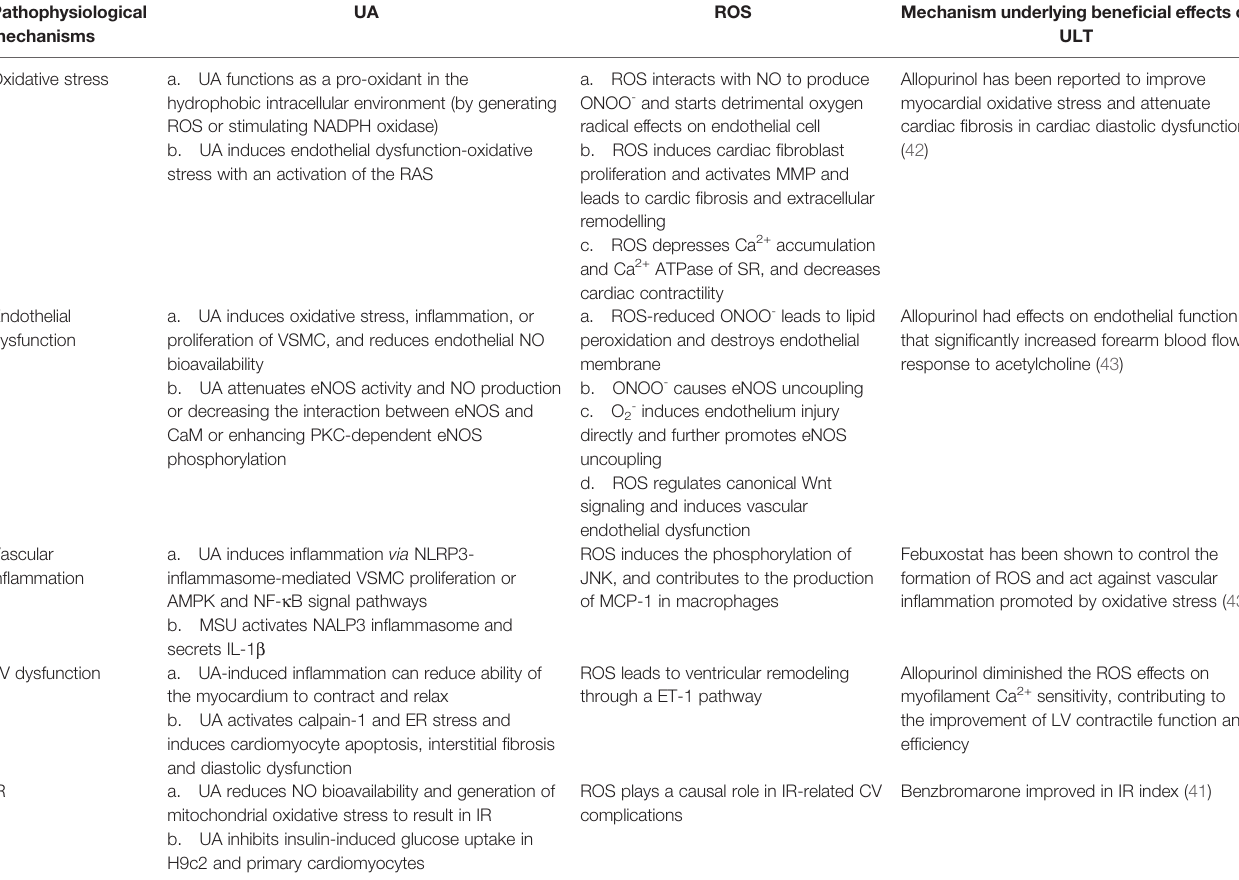
TABLE 2 | Pathophysiologic mechanisms of hyperuricemia in HF and potential effects of ULT. Pathophysiological UA ROS Mechanism underlying bene fi cial effects of mechanisms